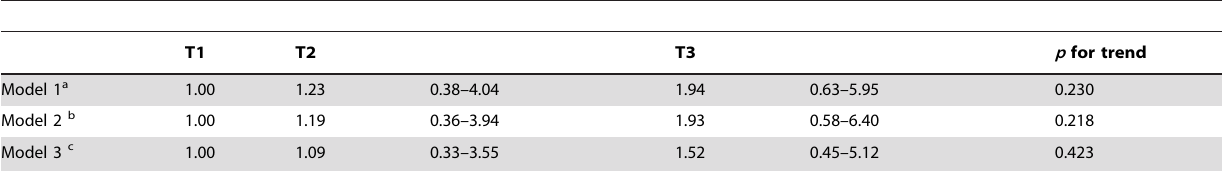
Table 3. Odds ratio (95%CI) for asthma according to MSG intake tertiles among Chinese adults (Jiangsu Nutrition Study) (n=1486).